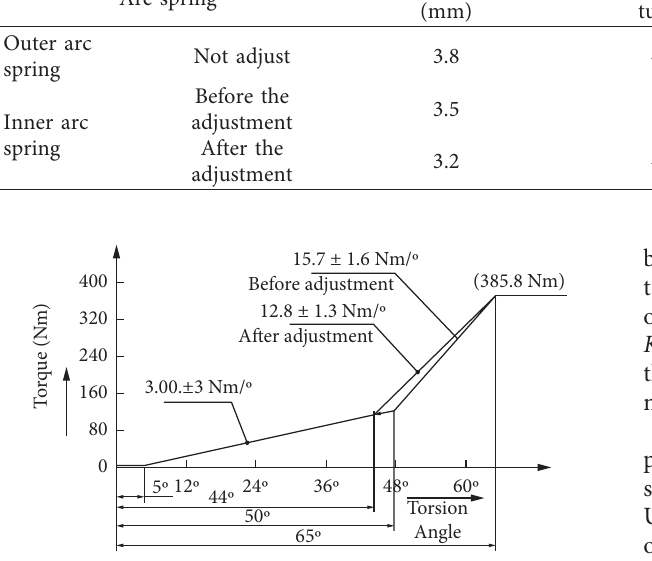
Figure 20: Vibration damping stiffness of DMF.